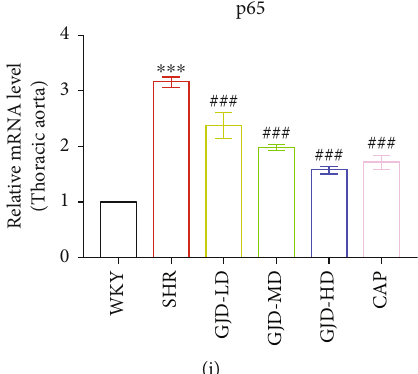
Figure 5: E ff ects of GJD on mRNA expression of interleukin-1 beta, interleukin-6, TNF-alpha, type I collagen, type III collagen, and alpha- SMA in the thoracic aorta. (a) Interleukin-1 beta, (b) interleukin-6, (c) TNF-alpha, (d) type I collagen, (e) type III collagen, (f) alpha-SMA, (g) TAK1, (h) IkB-alpha, and (i) p65. WKY indicates the WKY control group, SHR indicates the SHR model group, GJD-LD indicates the SHR treated with GJD at a low dose, GJD-MD indicates the SHR treated with GJD at a medium dose, GJD-HD indicates the SHR treated with GJD at a high dose, and CAP indicates SHR treated with captopril. Data are means ± SD . n = 3 . ∗ P < 0 : 05 , ∗∗ P < 0 : 01 , ∗∗∗ P < 0 : 001 vs. WKY group, # P < 0 : 05 , ## P < 0 : 01 , ### P < 0 : 001 vs. SHR group.